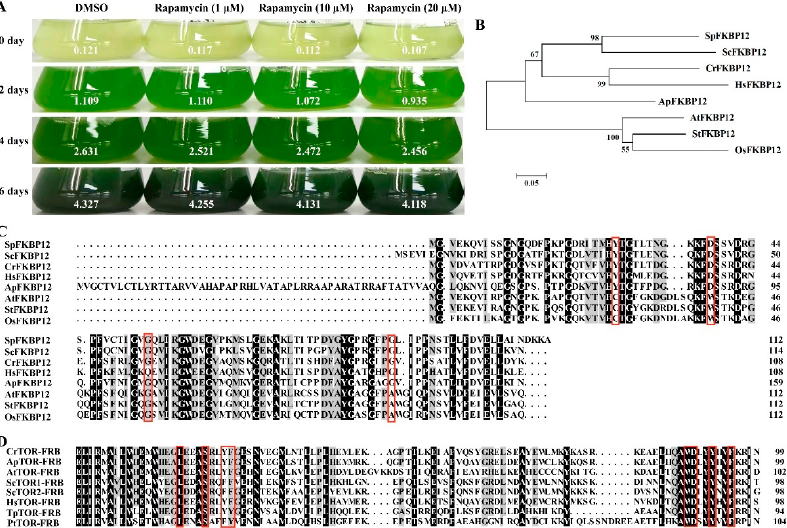
Figure 2. Auxenochlorella pyrenoidosa is resistant to rapamycin. ( A ) The phenotype of A. pyrenoidosa treated with different concentrations of rapamycin for 0, 2, 4, and 6 days. The numbers denote the corresponding OD680nm values. ( B ) The phylogenetic tree of ApFKBP12 protein and homologs from other species. Phylogenetic tree was constructed by MEGA 4 software using the Neighbor-Joining method. Numbers represent bootstrap percentages (1000 of bootstrap replicates). Schizosaccharomyces pombe (Sp) (Fungi, Ascomycota), Oryza sativa (Os) (Plantae, Tracheophyta), Solanum tuberosum (St) (Plantae, Tracheophyta). ( C ) Sequence alignment of the ApFKBP12 protein and homologs from other species. The red rectangle denotes the amino acid required for FKBP12 binding to rapamycin. ( D ) Sequence alignment of the FRB domains of the ApTOR protein and homologs from other species. The red rectangle denotes the amino acid required for the FRB domain binding to rapamycin.